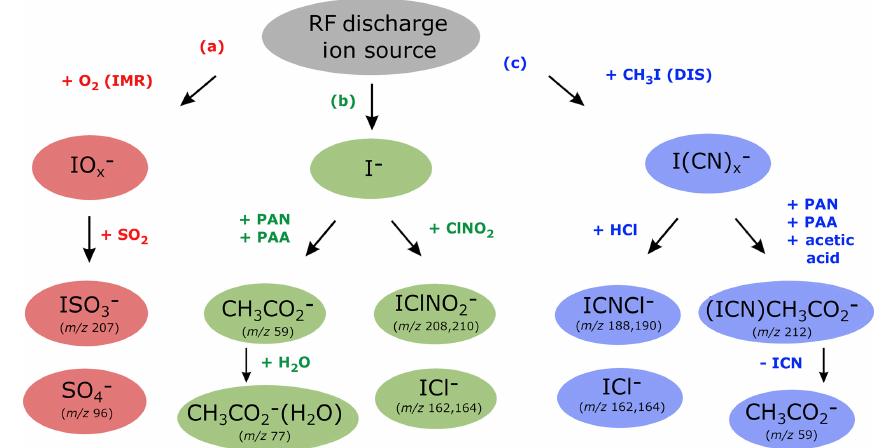
Figure 4. Ion detection schemes for SO 2 , PAN, PAA, acetic acid, ClNO 2 and HCl using the RF discharge ion source.